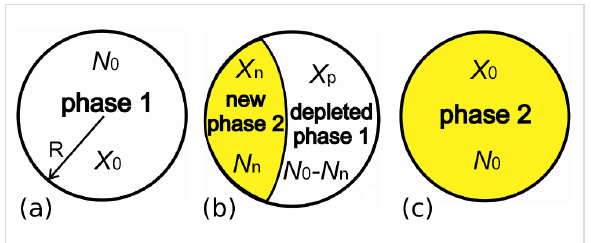
Figure 2: Possible phase transformation mode: an individual nano- metric particle of initial composition X 0 in single-phase state (a) and the same nanoparticle after new phase nucleation in two-phase con- figuration (b) and at the end of phase transformation (c). R – radius of spherical nanosized